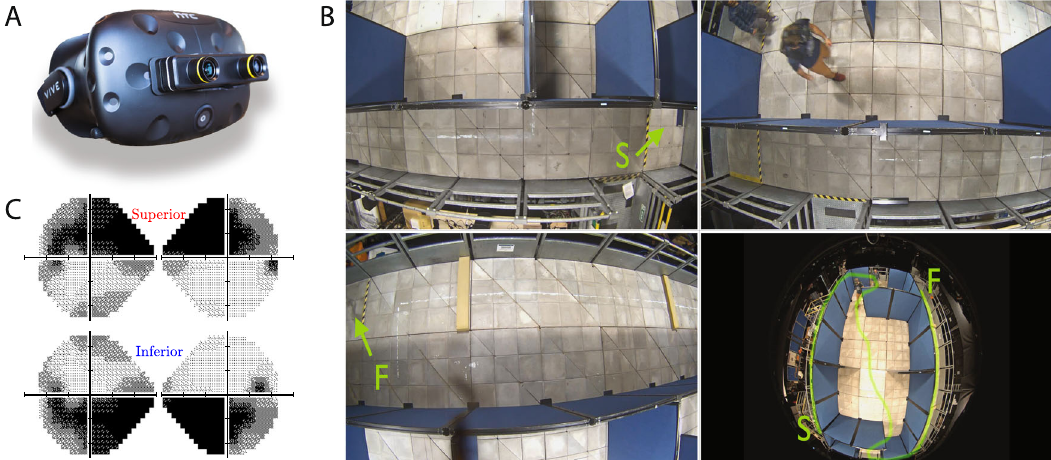
Fig. 3 AR Visual Mobility task methods. a Hardware: The modi fi ed HTC Vive headset, with ZEDmini stereoscopic cameras and integrated Tobii eye-tracking. b Task: Screenshots from four simultaneous camera feeds, recorded during a typical trial of the Visual Mobility task. The participant ’ s task was to trace an approximately ‘ s ’ shaped route (green line) from the start point [S] to the fi nish point [F]. The con fi guration of the blue partitions, and the exact location of the two foam obstacles (shown in bottom left panel), was varied randomly between trials. An experimenter followed the observer at a safe-distance in case of any trips or accidents. See Bainbridge et al. 59 for further details. c The simulated VFL conditions were the same as in the main experiment (Fig. 2). See Supplementary Video 3 for an example